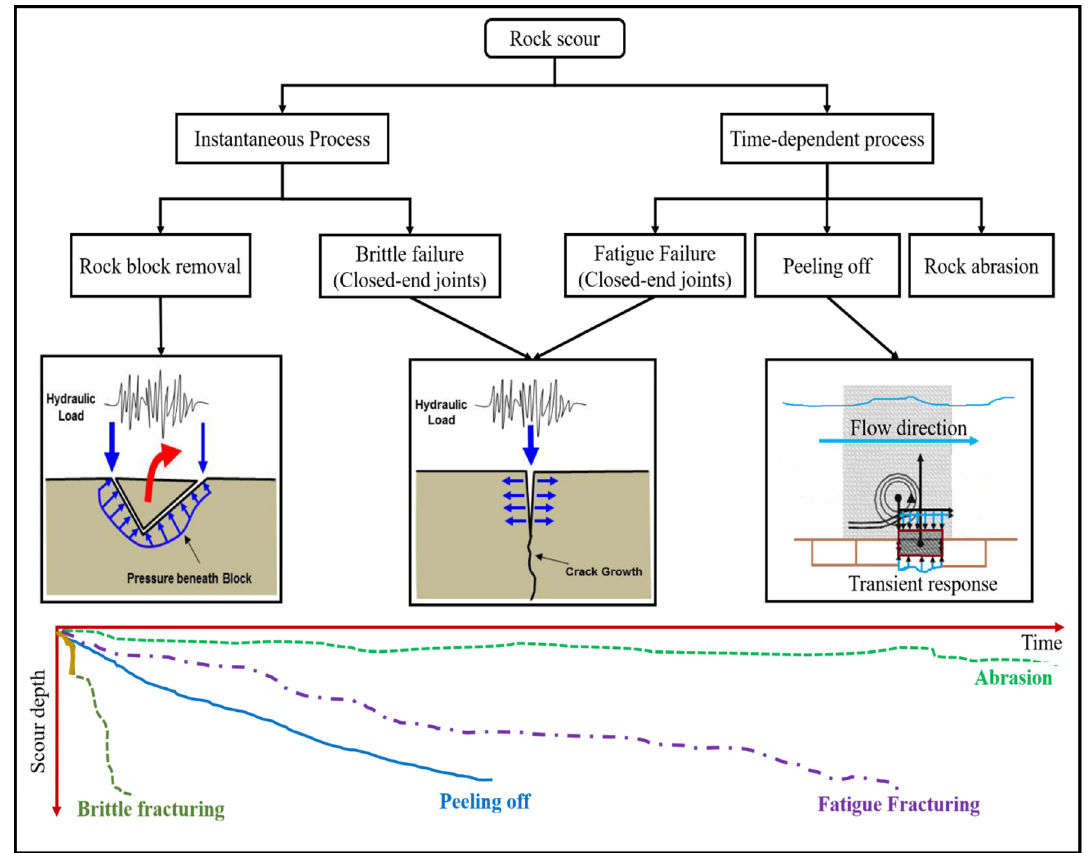
Figure 1. Main mechanical processes of rock erosion and the occurrence timescale [3]. The instantaneous processes consist of rock block removal and brittle failure. In the case of block removal mechanism, single rock blocks can be lifted by horizontal and ver- tical pressures. Along these lines, the stream turbulence, block size, block dimensions, bulge of the blocks, surrounding rock mass, joint roughness, and cohesion of filling as a shear destabilised force are relevant and effective parameters that straightforwardly characterise the lifting forces. the lifting